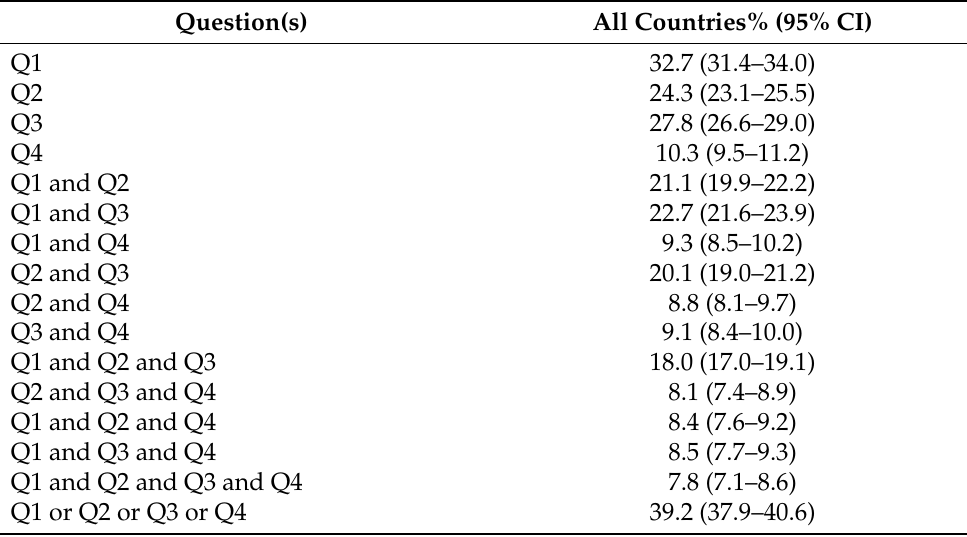
Table 2. Characteristics of the households included in the analysis by questions of food